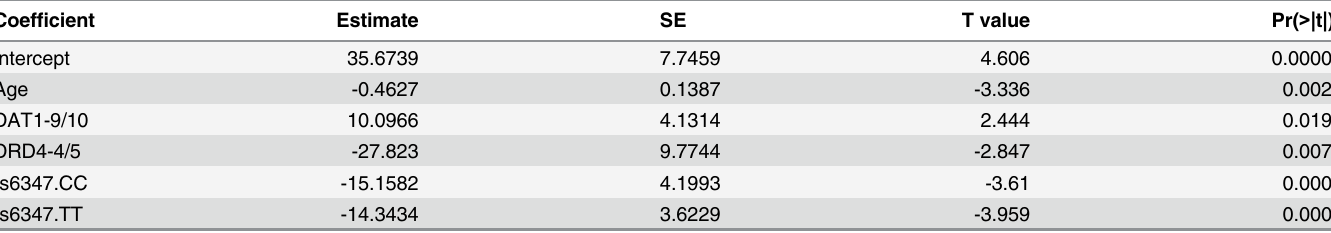
Table 4. Stepwise regression analysis results (n =